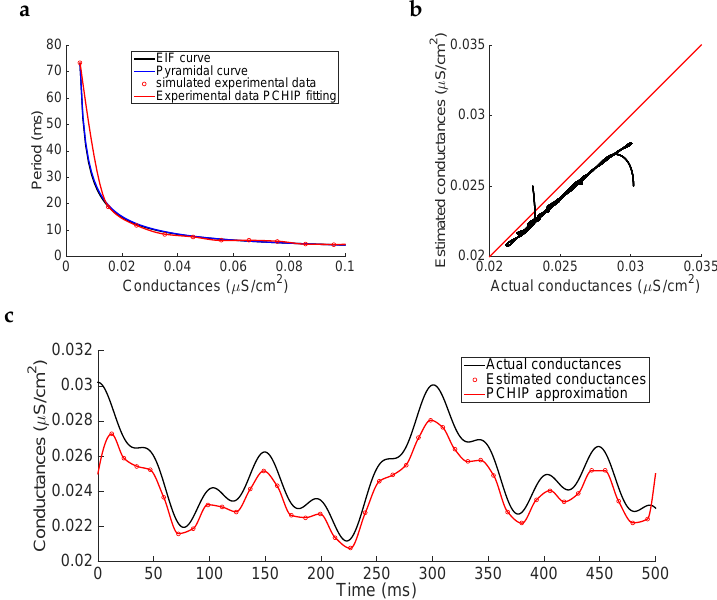
Figure 6. Results of the estimation procedure applied to a membrane potential generated through the pyramidal cell model with additive noise, and using a simulated T − g syn curve in the estimation procedure. Panel ( a ) shows the actual T − g syn curve (blue curve), the T − g syn curve obtained with the EIF method (black curve), a simulation of an experimental T − g syn curve (red dots), and an exponential fitting of the experimental curve (red curve). Panel ( b ) shows the scatter plot of the prescribed conductances versus the estimated ones; the red line represents the identity line. Panel ( c ) shows the prescribed conductances (black curve) and the estimated conductances (red curve). In panel ( a ), the experimental curve (red dots) has been computed using 10 different trials where noise has been added to the period (a random normal distributed value with 0 mean and 0.5 standard deviation) and the interpolated using the PCHIP